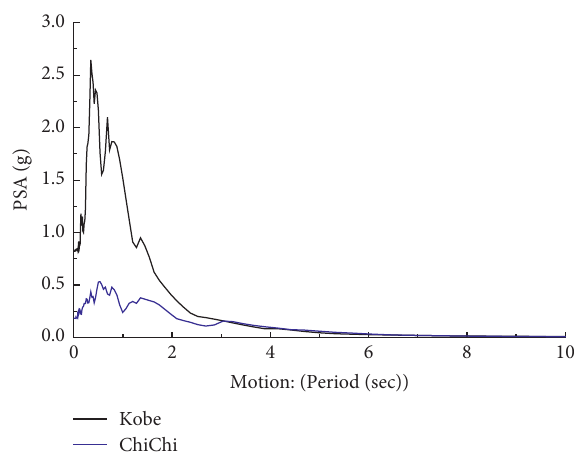
Figure 4: Response spectra of input motions.